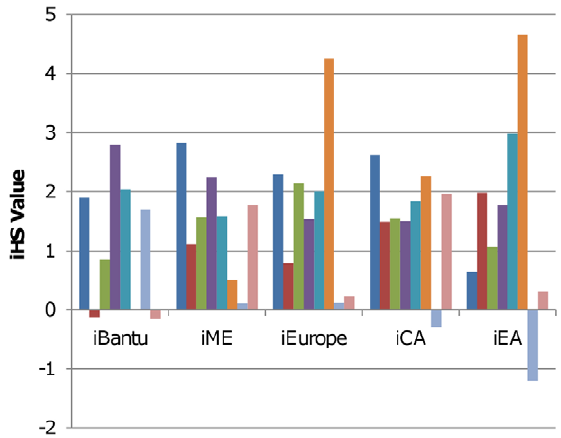
Figure 3. Delta, LLC, and iHS P-values for HIV/AIDS progression SNPs in Eurasia and East Asia. The figure displays p-values for specific Eurasian and East Asian delta, LLC, and iHS measures for HIV/ AIDS Progression SNPs. P-values for these measures are also shown for the Fellay et al. [33] study group in the unsigned group analysis. The blue bars represent rs17324272 at position 131,964,822 on chromo- some X. The red bars represent rs12012519 at position 87,077,005 on chromosome X. The green bars represent rs5968255 at position 83,141,348 on chromosome X. The purple bars represent the Fellay et al. [33] study